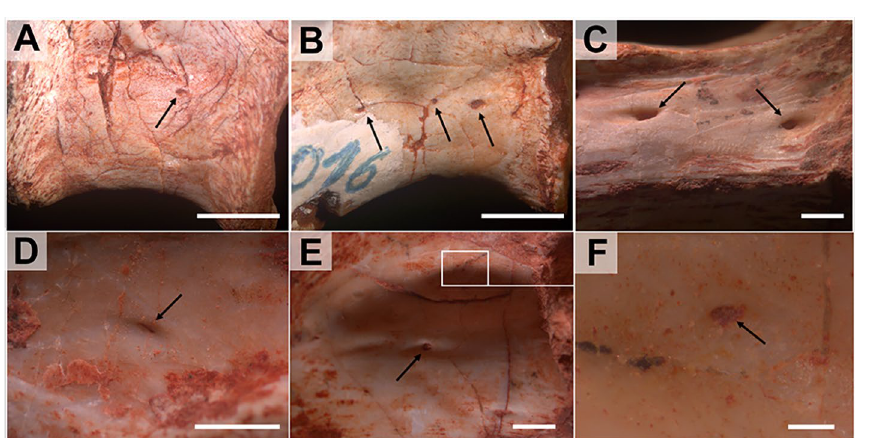
Figure 3. Detail of the vertebrae and foramina of the early sauropodomorph Pampadromaeus (ULBRA-PV016; ( A , B )) and the herrerasaurid Gnathovorax (CAPPA/UFSM-0009; ( C – F )). Anterior dorsal vertebrae in ( A , B ). Anterior cervical in C and posterior cervical in ( D – F ). Nutritional foramina are present on the lateral surface of the centra (small arrows) in ( A , B ) and ( D – F . They present a diminutive diameter when located inside the lateral fossae ( D – F ) and are broader on the ventral portion of the centra ( C ). Scale bar in ( A , B ) = 5 mm; in ( C – E ) = 1 mm; in ( F ) = 0.1 mm. Figures were generated with Adobe Photoshop CC version 22.5.1